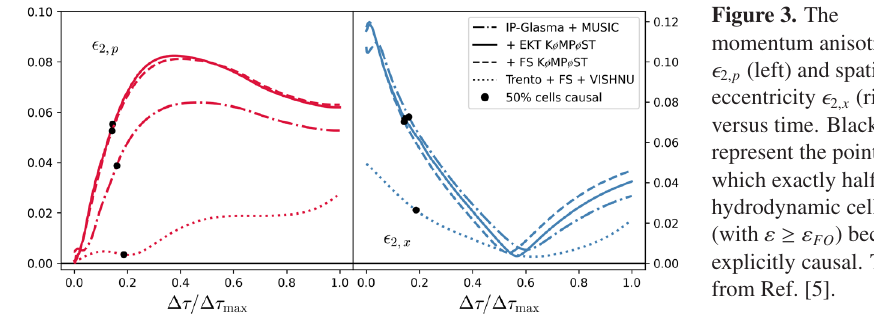
Figure 2. Characteristic velocities for PbPb collision in the IKM framework: Left: No KøMPøST, Middle: Free Streaming, Right: KøMPøST EKT. Taken from Ref. [5].